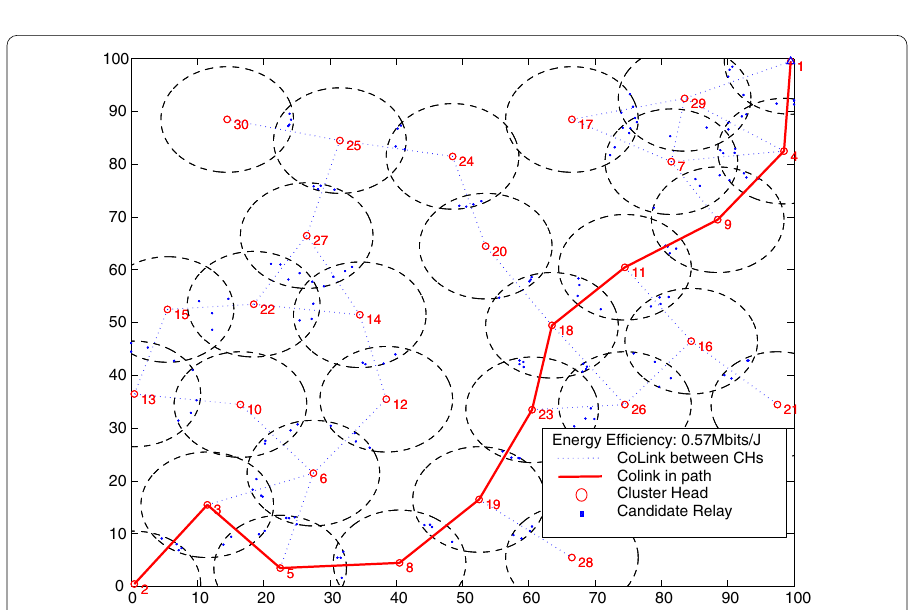
Fig. 9 An example for Path solution of EECSR under CH‑SWIPT